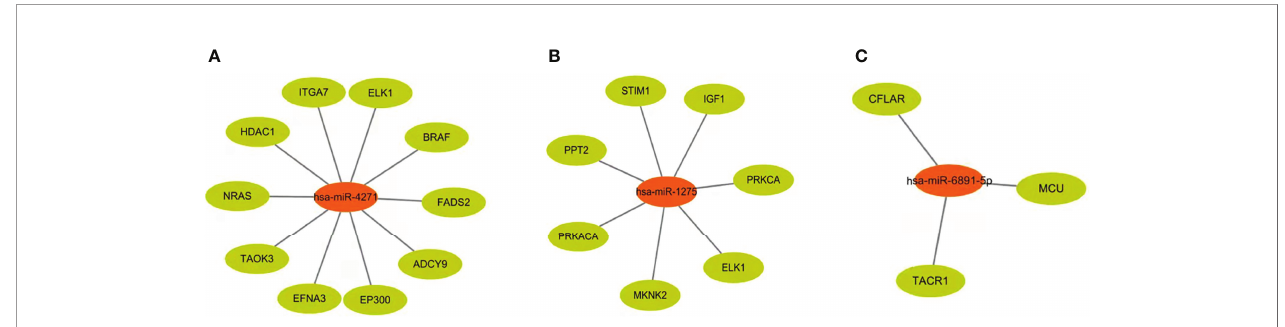
FIGURE 3 | Target genes of differentially expressed serum exosome miRNAs. (A) Target genes associated with hsa-miR-4271. (B) Target genes associated with hsa-miR-1275. (C) Target genes associated with